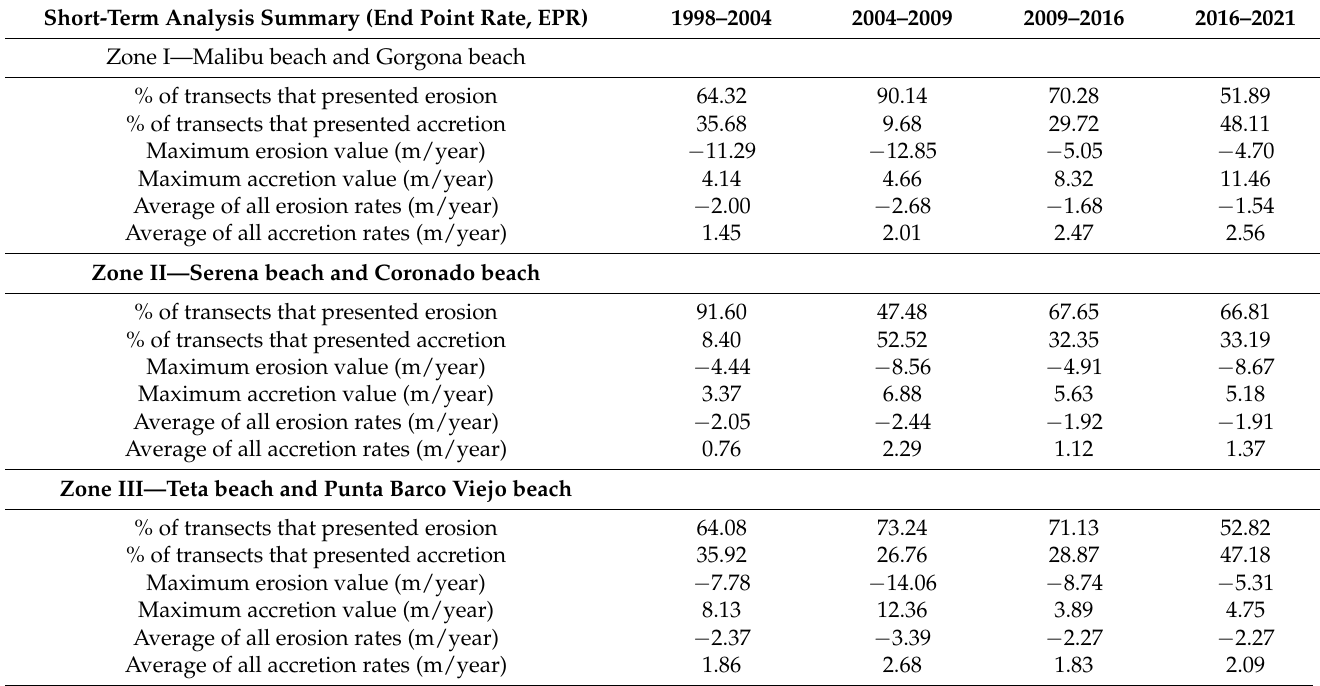
Table 7. Summary of the results obtained for the short-term